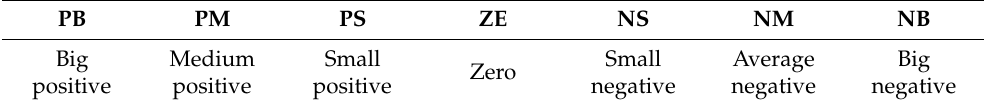
Table 2. Fuzzy variable